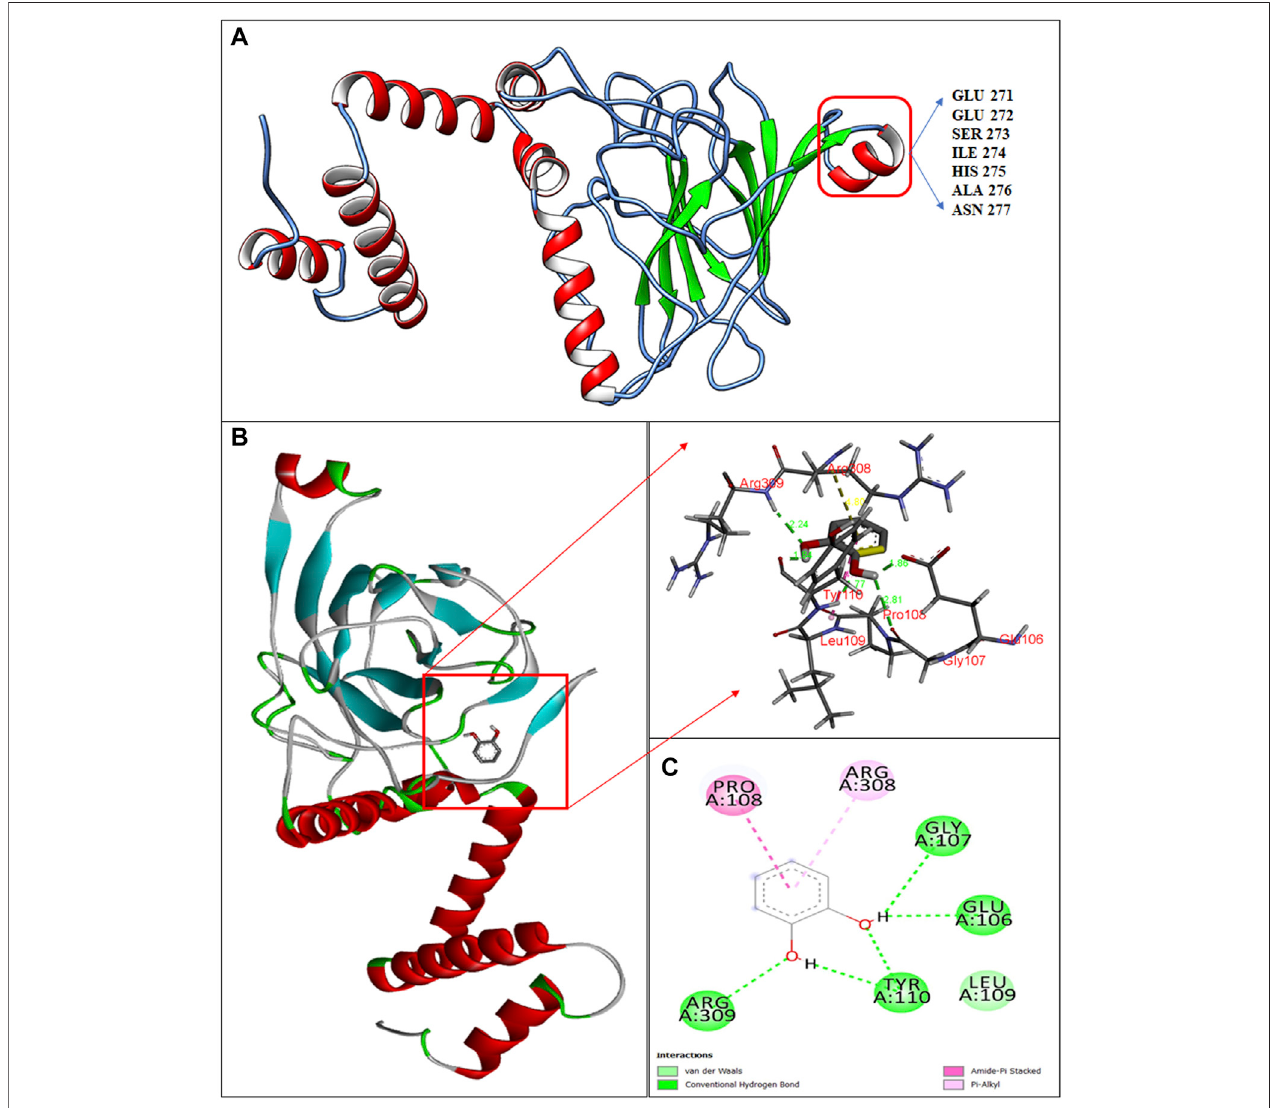
FIGURE 3 | Structural insights in to catechol binding sites in C12O enzyme from Paracoccus sp. MKU1. (A) 3D structure of C12O with catechol, (B) Enlarged image of molecular interaction of C12O with catechol, (C) 2D interaction of catechol with speci fi c amino acids of C12O enzyme.